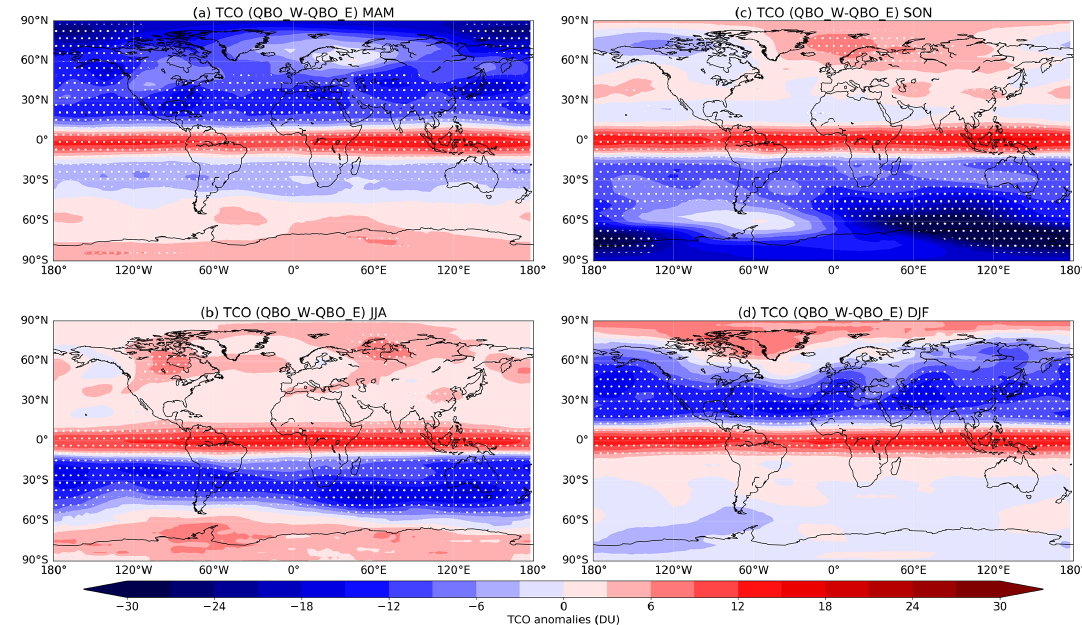
Figure 3. Influences of QBO (QBOW–QBOE) on global total column ozone (TCO) in different seasons based on MSR2 data 1979–2020. (a) MAM. (b) JJA. (c) SON. (d) DJF. Stippled areas indicate results that are statistically significant over the 95% level, using the two-tailed Student’s t test.